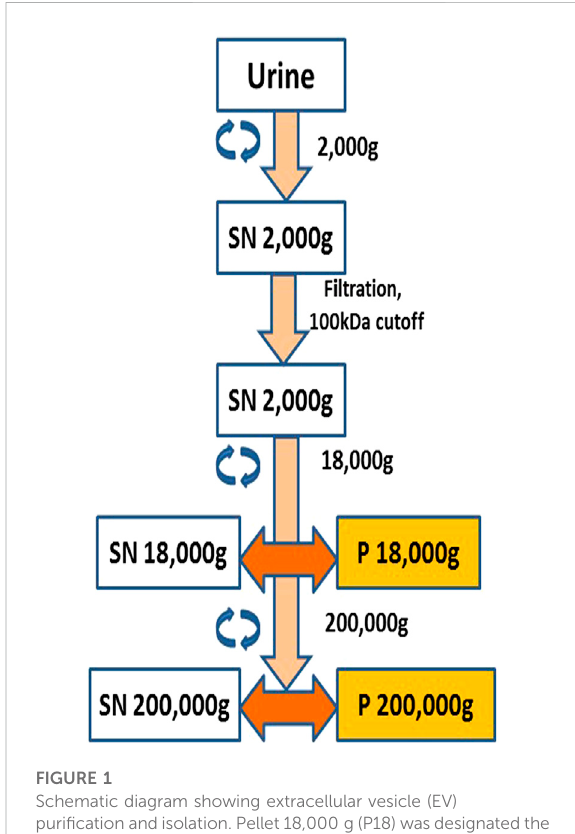
FIGURE 1 Schematic diagram showing extracellular vesicle (EV) puri fi cation and isolation. Pellet 18,000 g (P18) was designated the microvesicles pellet and Pellet 200,000 g (P200) was designated the exosomes